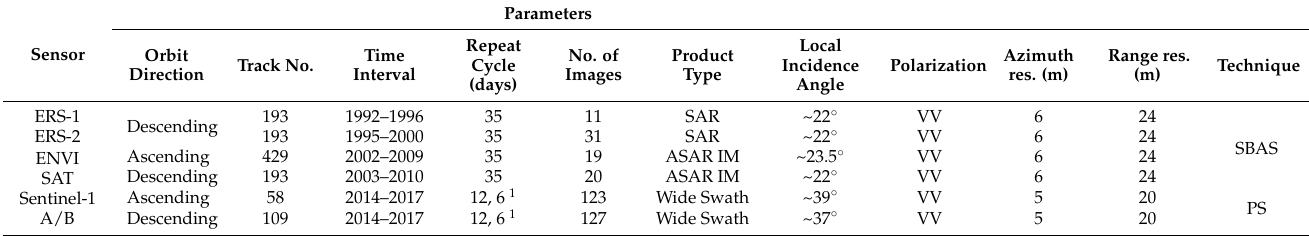
Table 1. Specific parameters of SAR image datasets that were used in this study.